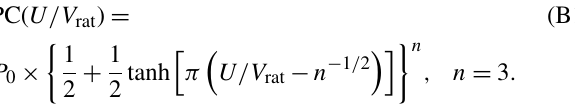
3 % for an input roughness uncertainty ( (cid:49)z 0 / (cid:104) z 0 (cid:105)